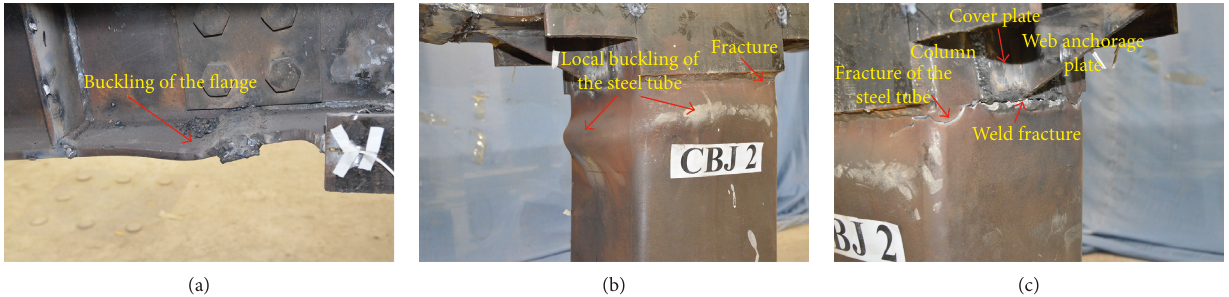
Figure 11: Failure modes of CBJ2: (a) the left beam; (b) buckling of the column; (c) weld fracture of the tube.